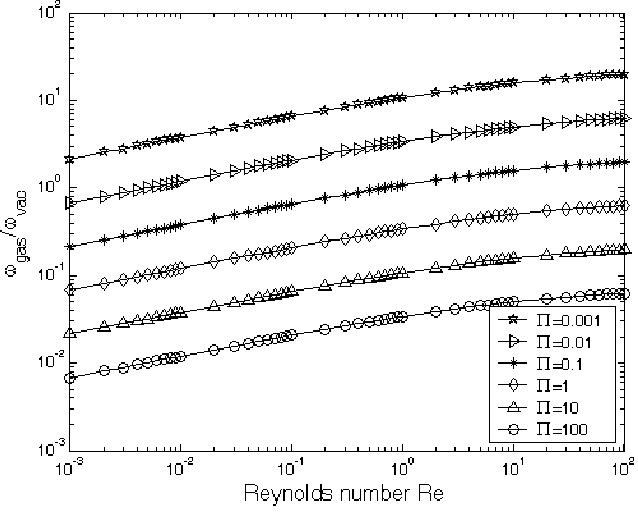
as a function of the Reynolds number R gas